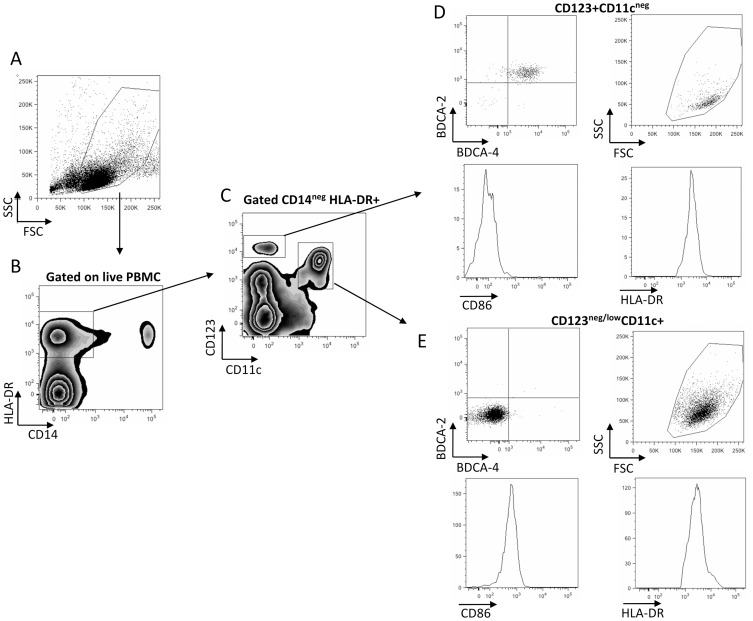
Phenotyping DCs.Live PBMCs (A) are gated on CD14negHLA-DR+ cells (B) which subsequently are analysed for the expression of CD11c and CD123 (C). CD123+CD11cneg (D) and CD123neg/lowCD11c+ (E) were subsequently analysed for the expression levels of BDCA-2/CD303 and BDCA-4/CD304, CD86 and HLA-DR. Presented plots are an example and derived from a 5 year old female individual.